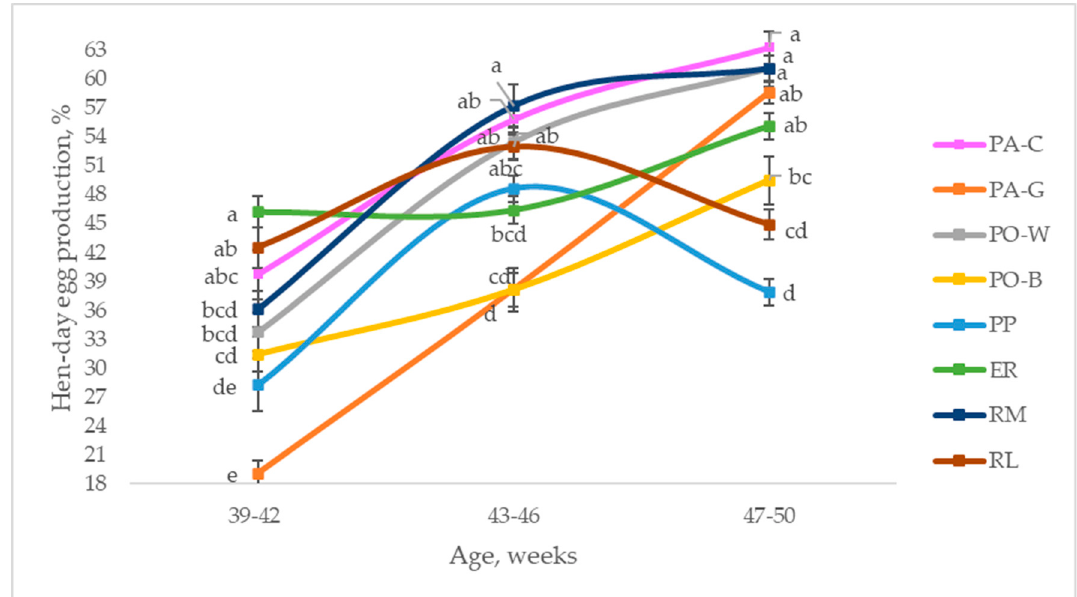
Figure 2. Least squares means (with SE) of hen ‐ day egg production according to the age of the hens (from 39 to 42 weeks; from 43 to 46 weeks; from 47 to 50 weeks; observations ( n ) = 28 per period and breed). PA ‐ C: Padovana Camosciata; PA ‐ G: Padovana Dorata; PO ‐ W: Polverara Bianca; PO ‐ B: Polverara Nera; PP: Pepoi; ER: Ermellinata di Rovigo; RM: Robusta Maculata; RL: Robusta Lionata. Different letters between breeds within age indicate statistically different means (a,b,c,d,e: p < 0.05). The hen ‐ day egg mass (Figure 3), which refers to the age of the egg sampling (49–50 weeks), shows higher values for PA ‐ C, PA ‐ G, and RM than RL. PO ‐ W and ER were intermediate, and PO-B and PP were the lowest ( p < 0.05). For the white-eggshell breeds, PO-B was the lowest, and for the tinted eggshell breeds, the lowest were RL and PP ( p < 0.05).